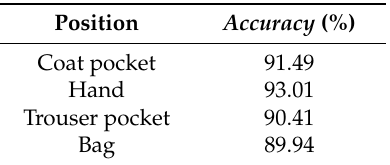
Table 6. Accuracy of different